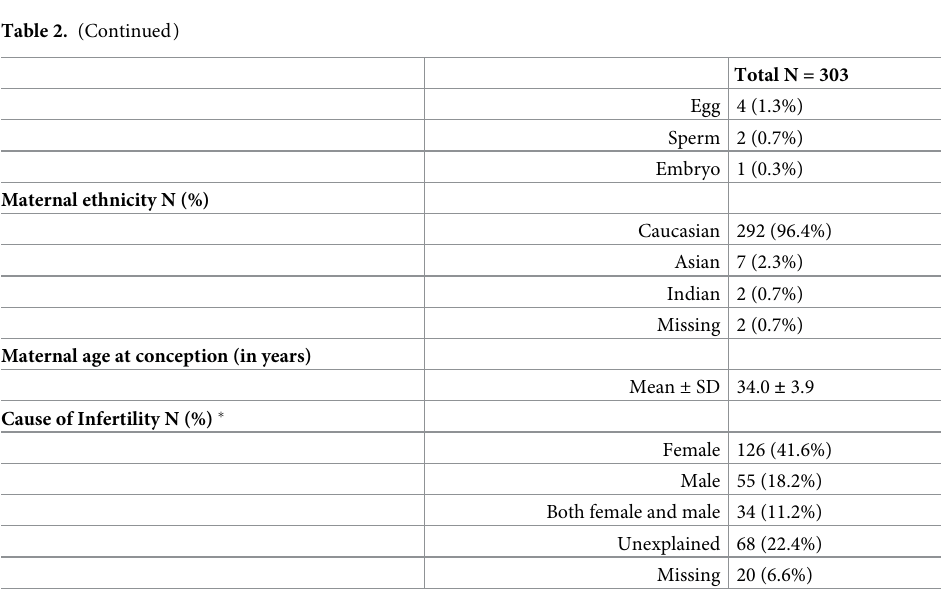
IVF: In vitro fertilisation; ICSI: Intracytoplasmic sperm injection; GIFT: Gamete intrafallopian transfer; IUI: Intra